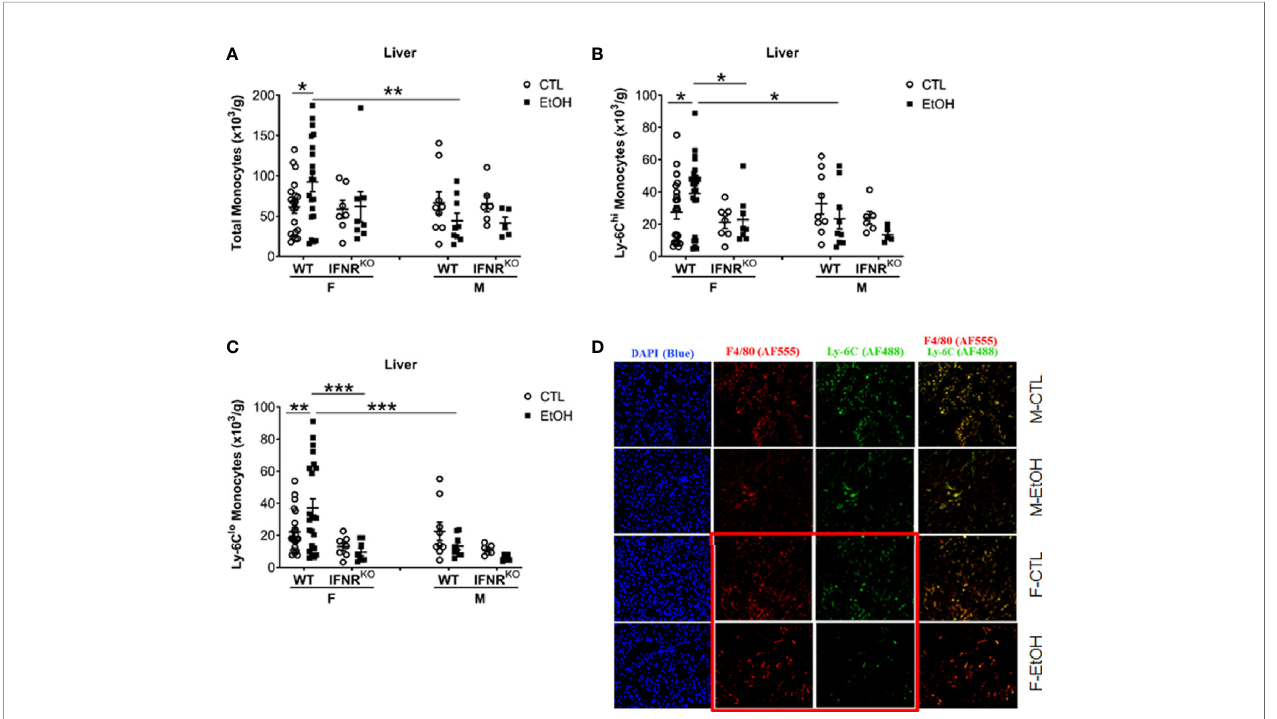
FIGURE 1 | Alcohol induced increase in hepatic MDMs in female mice. Female (F) and male (M) From wild type (WT) and interferon a / b receptor 1-knockout (IFNR KO ) mice were provided a regular chow diet and ethanol in drinking water (EtOH) or ethanol-free water (CTL). After 4 weeks, mice were euthanized, and Liver harvested. (A – C) Hepatic leukocytes were stained and analyzed by fl ow cytometry. Dot graphs showing the numbers of total monocytes (A) , Ly-6C hi monocytes (B) , and Ly-6C lo monocytes (C) per gram of liver weight. Values are showing the mean ± SEM, *p<0.05, **p<0.01, ***p<0.001. n ≥ 5. (D) Images are showing liver tissue stained with fl uorescent-labeled antibodies, anti-F4/80 (AF555/red), anti-Ly-6C (AF488/green), and DAPI